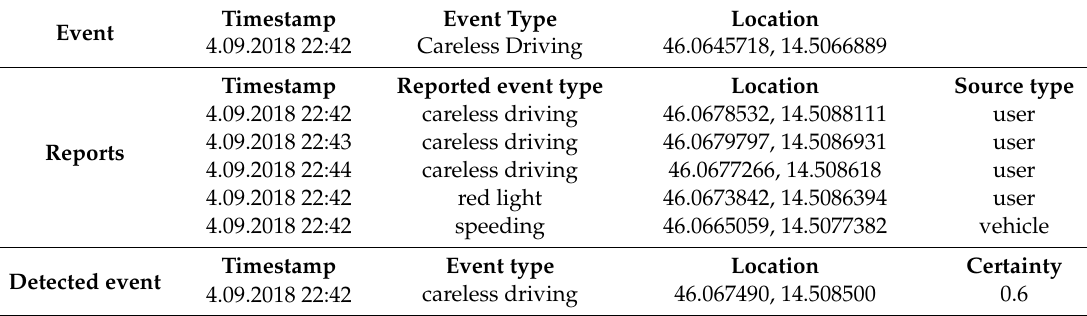
Table 2. Example of event reports, and the detected event.